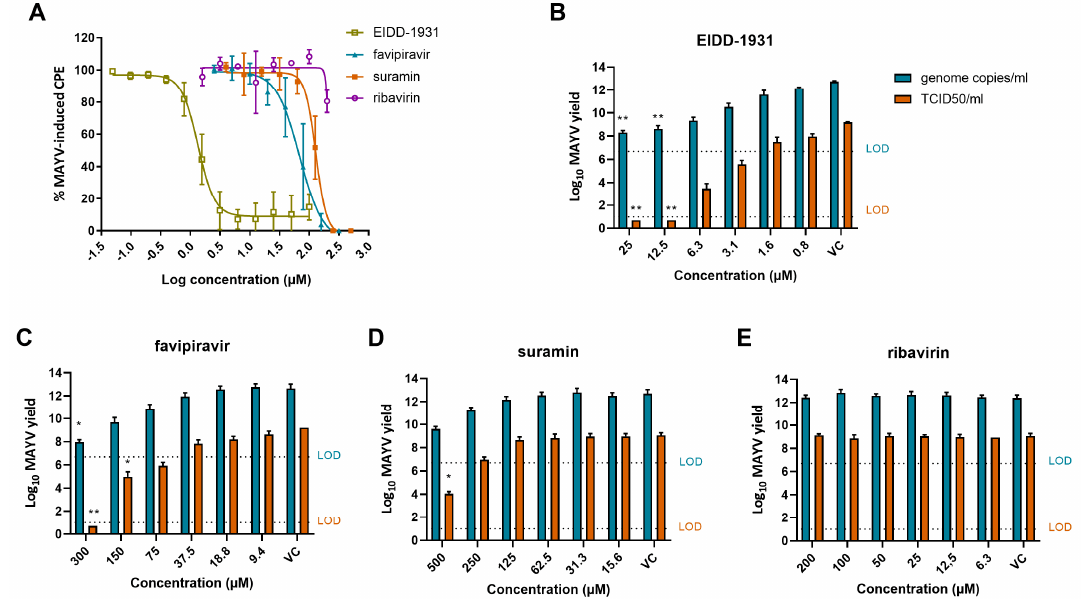
Figure 2. In vitro antiviral effect of EIDD-1931, favipiravir, suramin and ribavirin in Vero cells. ( A ) Dose–response effect of EIDD-1931, favipiravir, suramin and ribavirin on MAYV-induced CPE (MOI 0.01), quantified in Vero cells by the MTS/PMS method. Data shown are mean values ± standard deviations (SD) from three independent experiments. ( B – E ) The effect of different concentrations of ( B ) EIDD-1931, ( C ) favipiravir, ( D ) suramin and ( E ) ribavirin on the release of MAYV particles by infected Vero cells (MOI 0.01). Both viral RNA (genome copies/mL; blue) and infectious progeny virus (TCID 50 /mL; orange) were quantified at 48 h pi by real-time qRT-PCR and end-point titrations, respectively. Data shown are mean values ± SD from three independent experiments. Significant differences from untreated virus control were analyzed by Kruskal–Wallis test (*, p < 0.05; **, p < 0.005). CPE, cytopathogenic effect; TCID, tissue culture infectious dose; VC, virus control (untreated); LOD, limit of